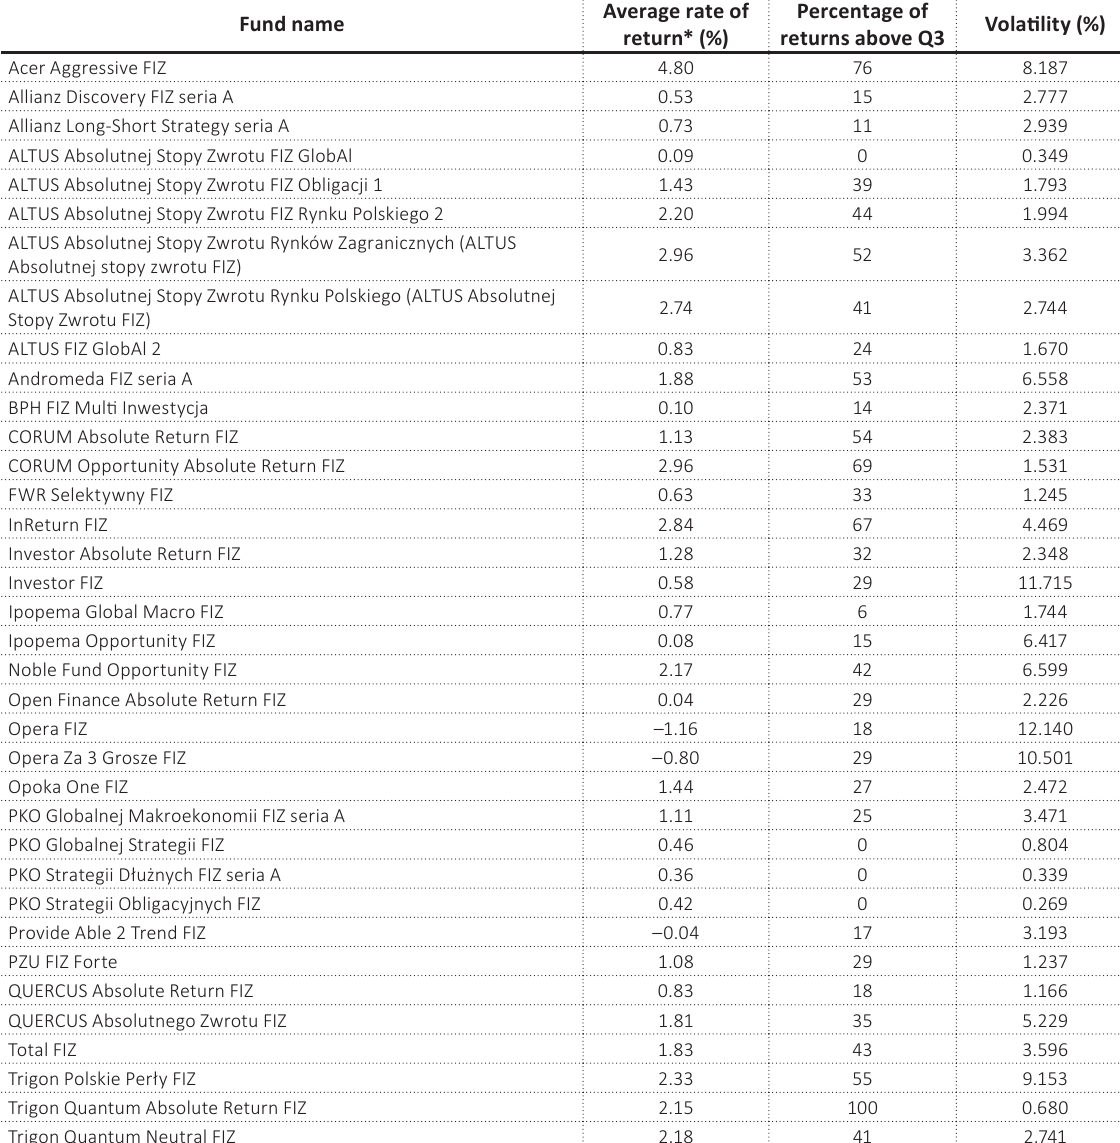
Table 4. Quarterly return and risk for FIZ in